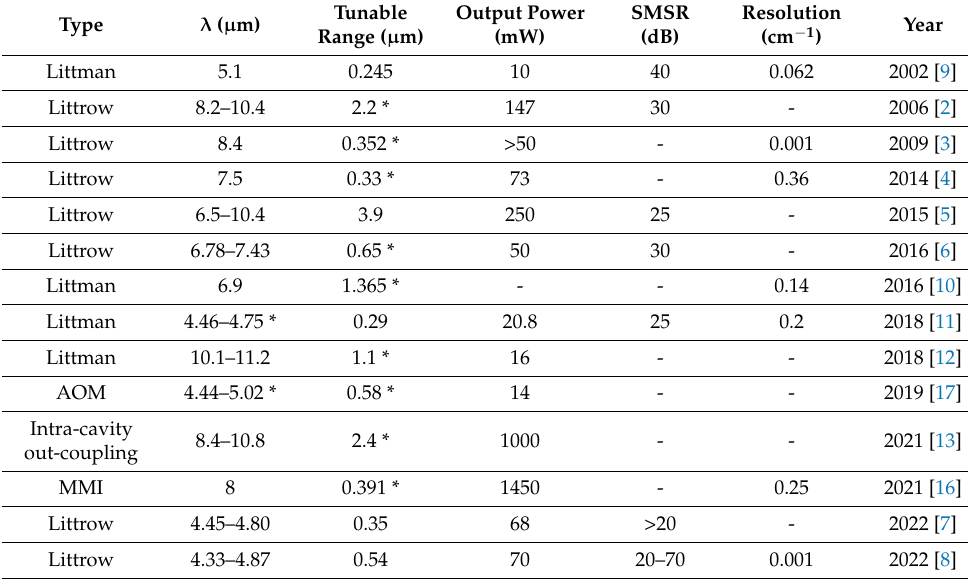
Table 1. The performance parameters of ECQCLs in recent